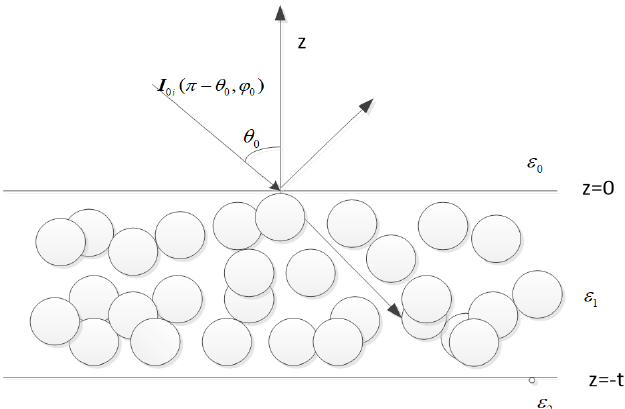
Figure 1. Model microwave emission behavior for multilayer